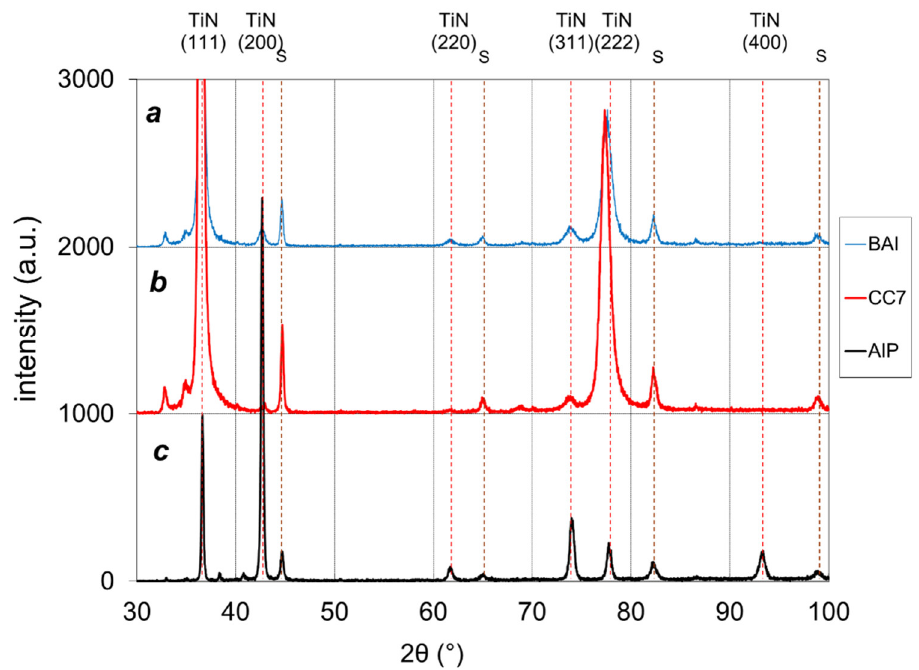
Figure 6. XRD spectra of TiN coatings deposited by low-voltage electron beam evaporation (a), magnetron sputtering (b), and cathodic arc deposition (c).